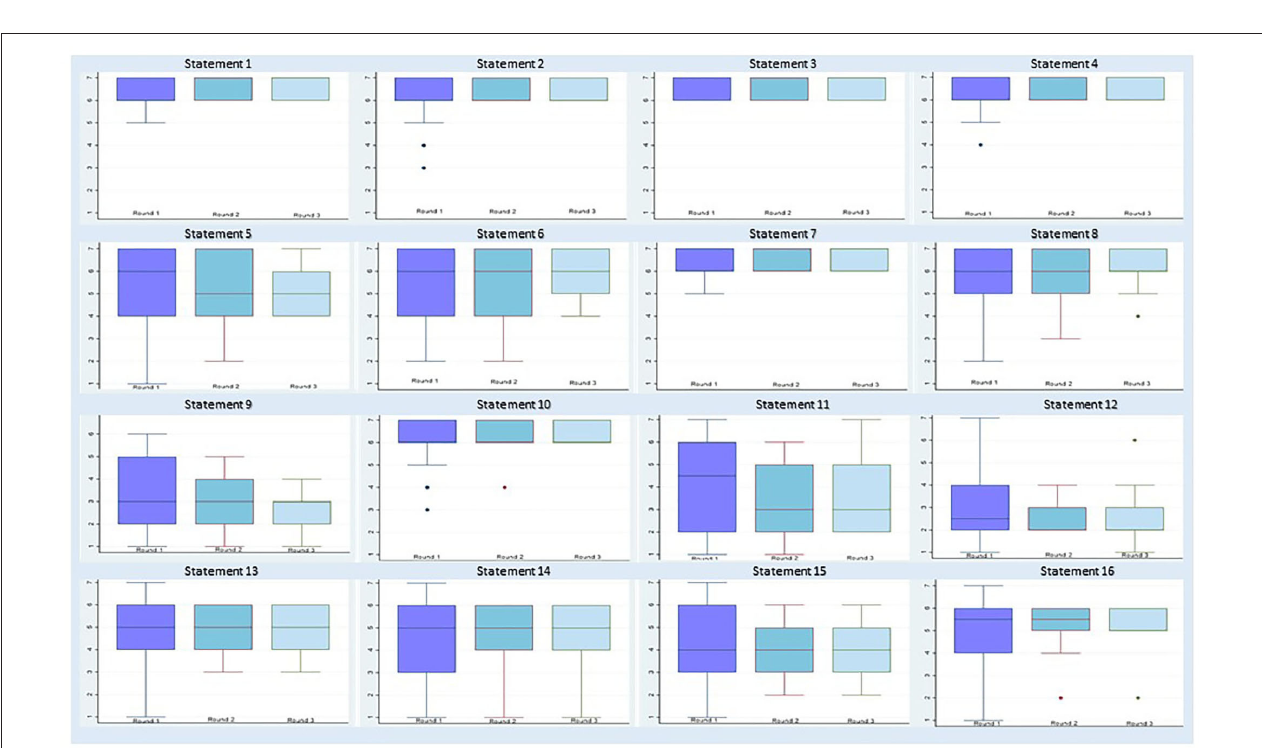
FIGURE 2 | Distribution of responses for each item per